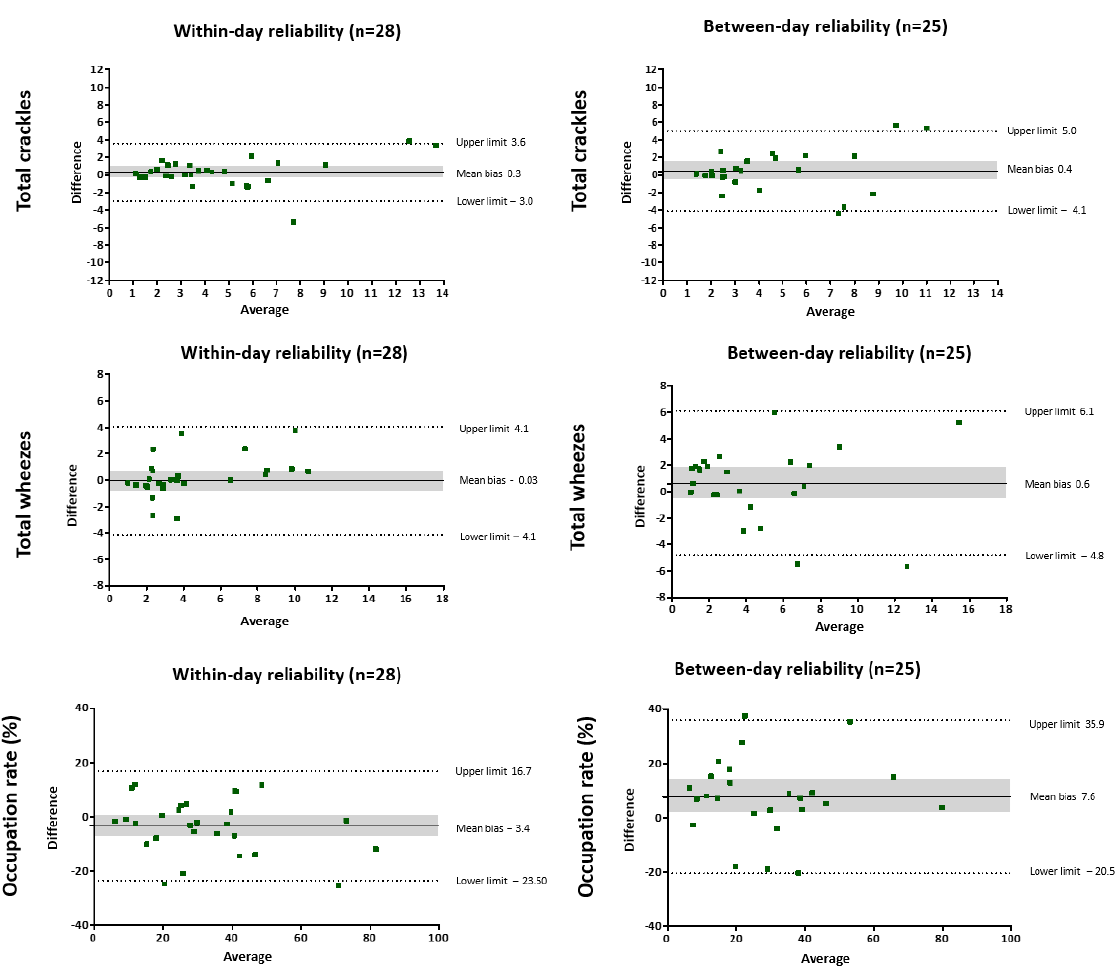
Figure 2. Bland-Altman plots for total number of crackles, wheezes and occupation rate considering both respiratory phases for within-day reliability (1 min apart) and between-day reliability (1 week apart). The solid line represents the mean difference between both measurements, dotted lines represent the 95% upper and lower limits of agreement and shared areas represent the 95% confidence interval for mean difference. Table 2. Within-day and between-day reliability of crackles during the inspiration, expiration and complete respiratory cycle and per chest location.